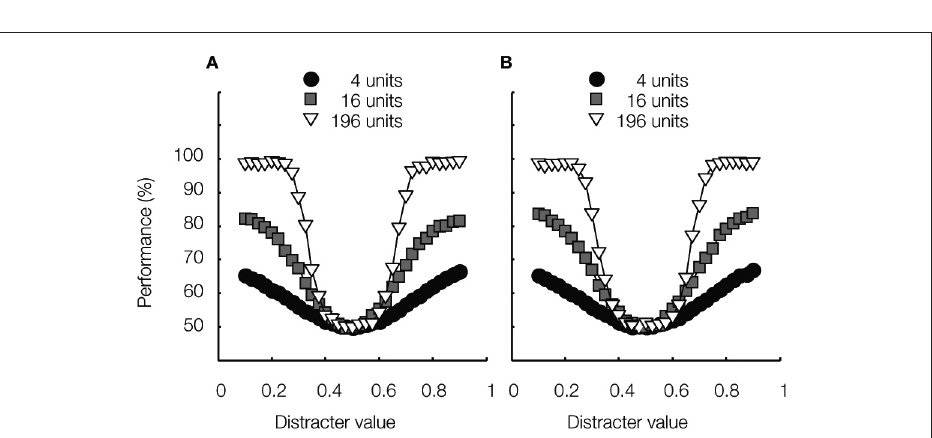
Figure 5 | Learned invariance. Average classification performance is plotted as a function of distracter value for three different network sizes, consisting of 4, 16 and 196 units, respectively. These networks were trained to perform identification at all five locations on the irrelevant dimension. (A) The test stimuli’s location on the irrelevant dimension is indicated by the black arrow in Figure 3A. (B) The test stimuli’s location on the irrelevant dimension is indicated by the lightest arrow in Figure 3A. These results were not part of the simulations in Goris and Op de Beeck